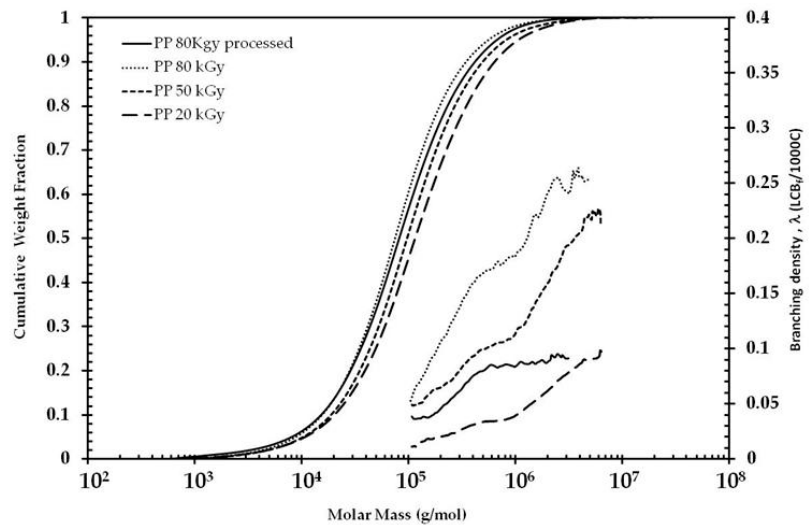
Figure 7. Branching density λ (LCB/1000C) and cumulative molar mass distribution for irradiated PP samples obtained by triple detection GPC ‐ SEC.